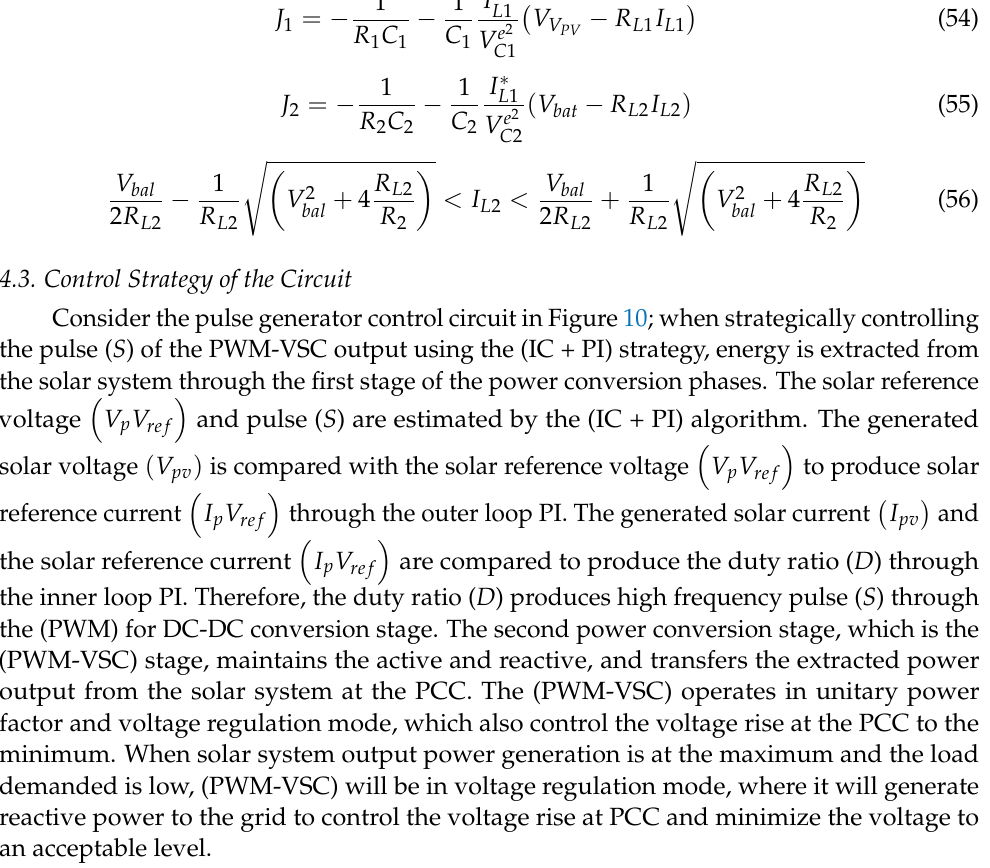
Figure 10. Pulse generator.